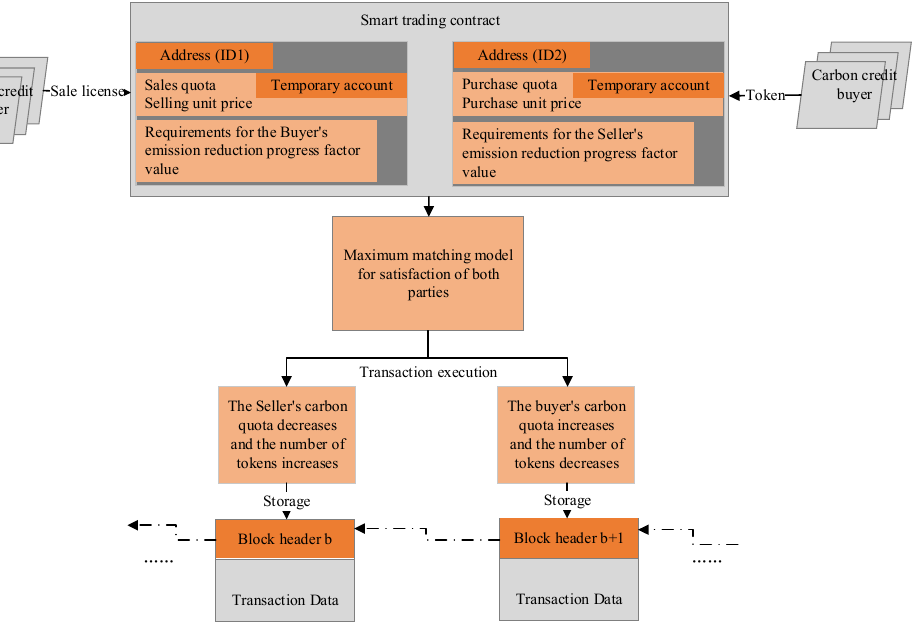
Figure 3. Matching model of urban public transport carbon quota transaction based on blockchain Matching model of urban public transport carbon quota transaction based on technology. blockchain